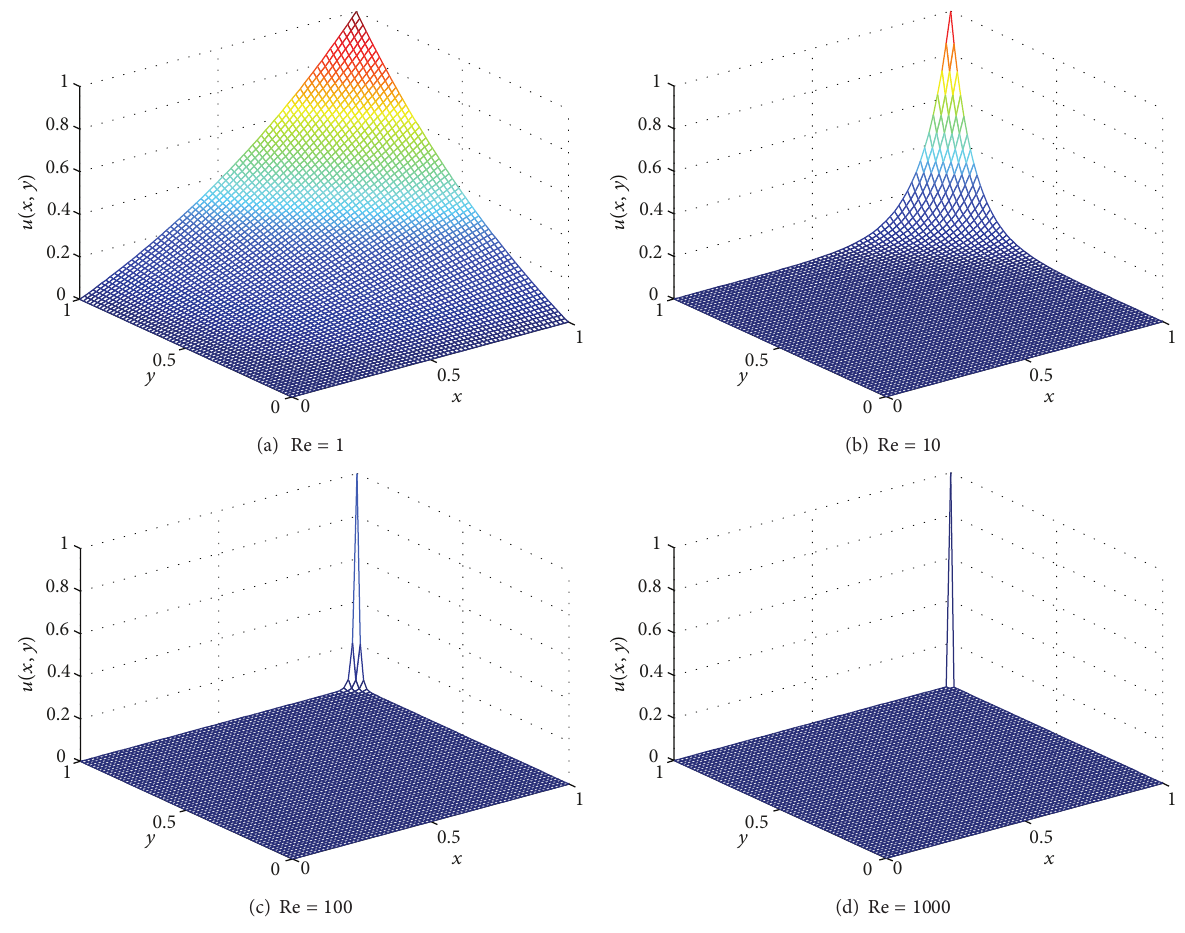
Figure 2: Exact solution of Example 7 for different values of Re.